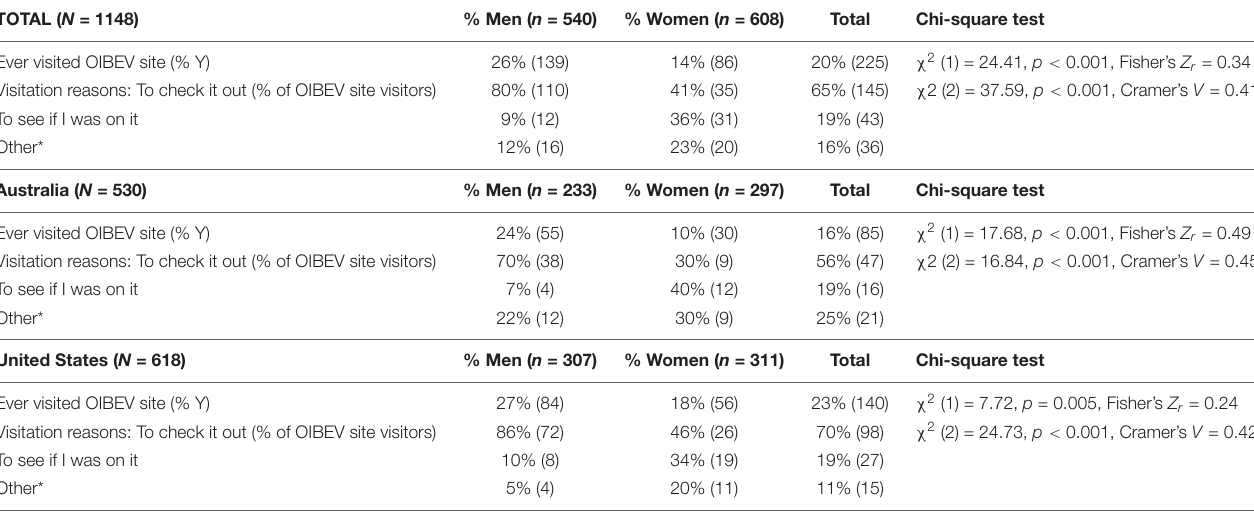
TABLE 1 | Descriptive statistics and chi square comparisons by gender for OIBEV site visitation and visitation reasons. TOTAL ( N = 1148)